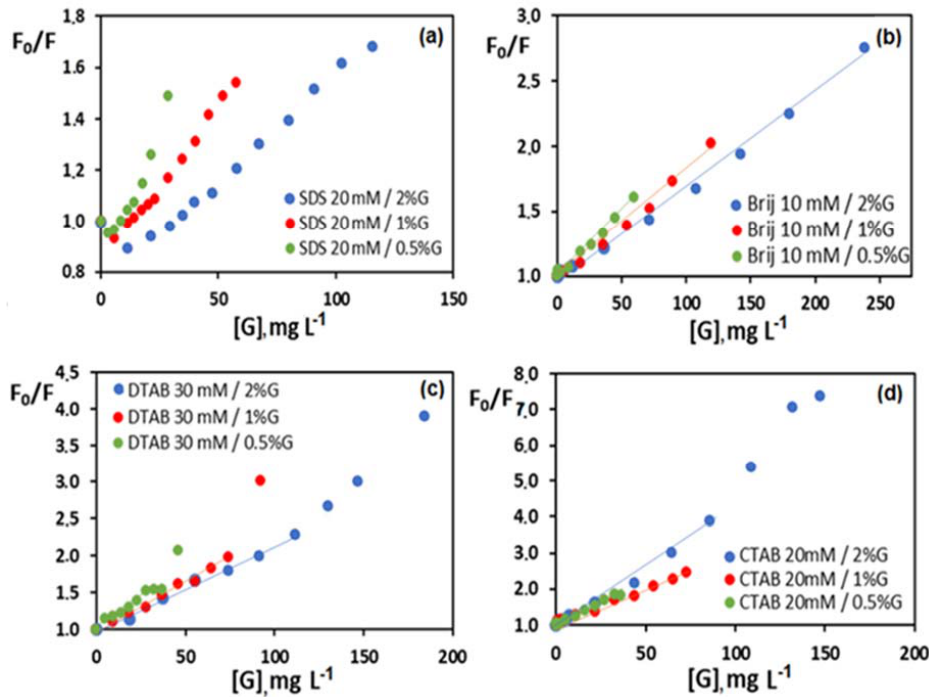
Figure 10. Ratio of the fluorescence intensity of vitamin B 6 ( λ exc = 325 nm; λ em = 395 nm) in the absence (F o ) and in the presence (F) of G dispersed in: ( a ) 20 mM SDS; ( b ) 10 mM Brij L23; ( c ) 30 mM DTAB; and, ( d ) 20 mM CTAB vs. G concentration (mg L − 1 ) for dispersions with a constant w G /w S . Table 1. Quenching constants (K) calculated from F 0 /F plots vs. G concentration for dispersions with a constant w G /w S in the linear concentration range. In the case of SDS, it was not possible to attain a straight line with intercept 1.